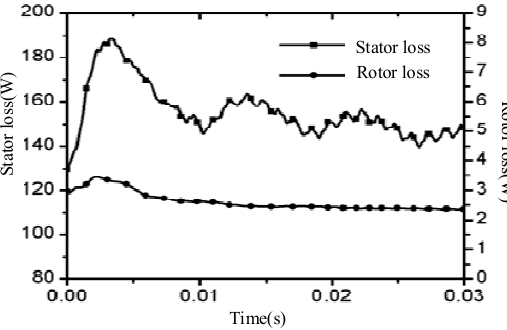
Figure 10. The core loss of the stator and rotor.